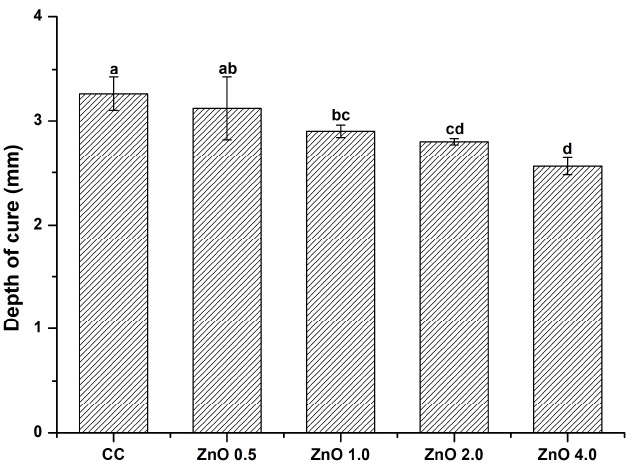
Figure 7. Depth of cure. Different letters indicate significant differences ( p < 0.05). The error bars show the standard deviation of the mean values.